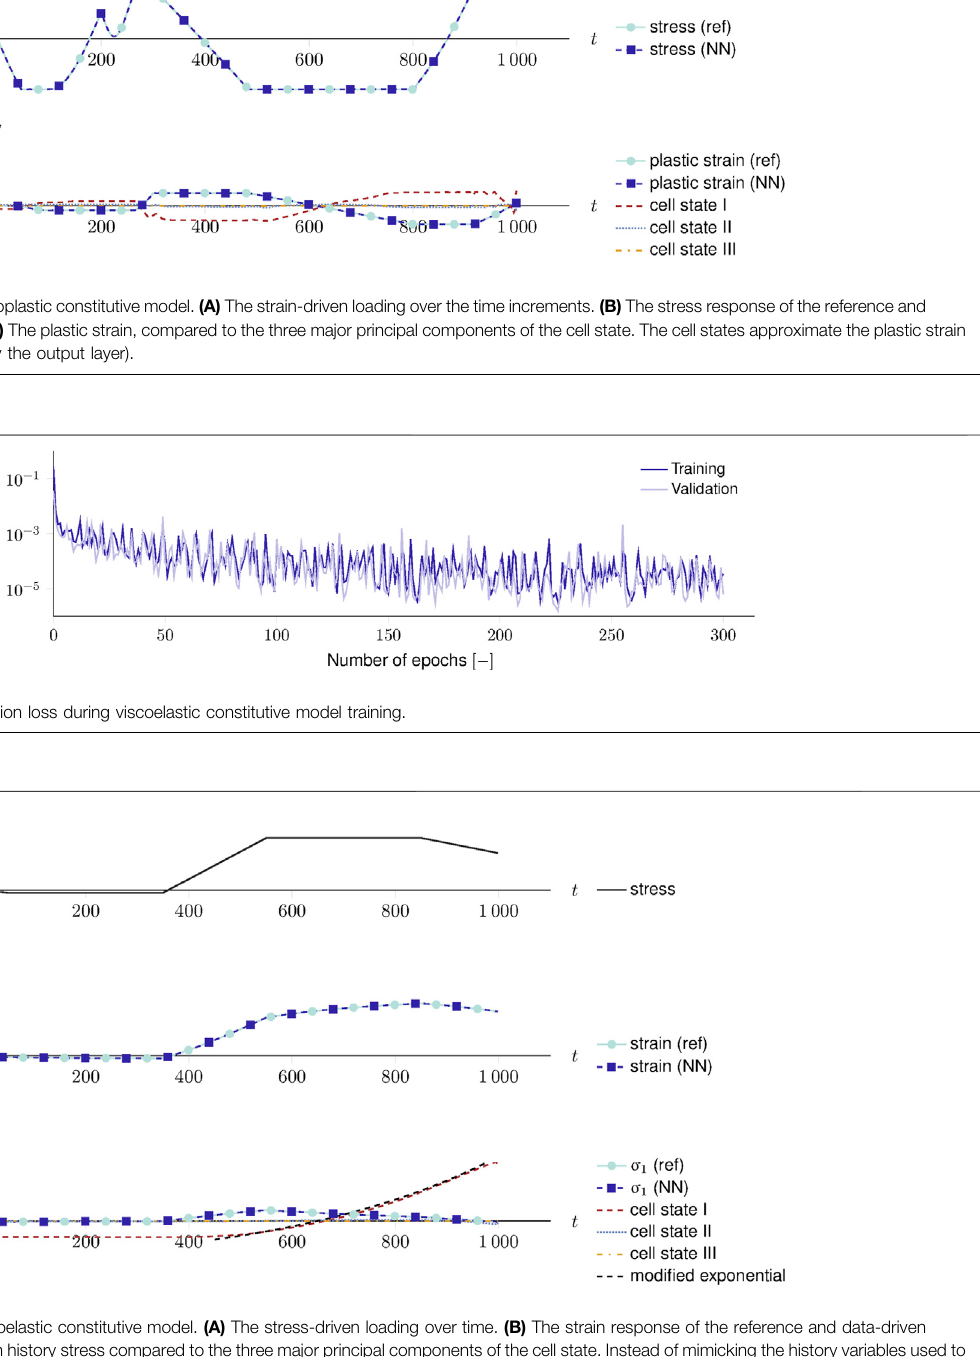
Frontiers in Materials |